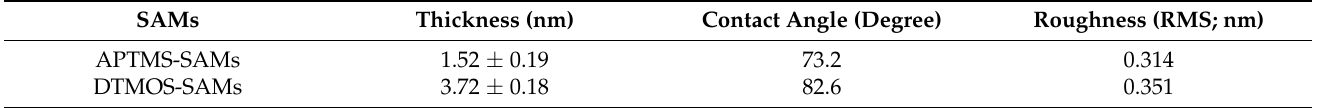
Table 2. Properties of the formation SAMs derived from APTMS and DTMOS molecules. SAMs Thickness (nm) Contact Angle (Degree) Roughness (RMS;